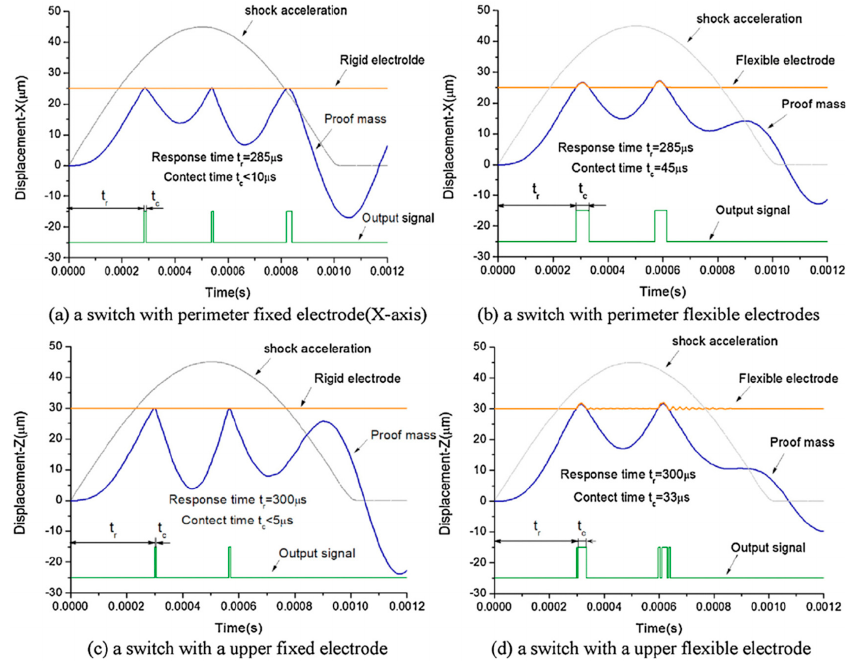
Figure 10. Simulated displacement–time curves of the proof mass in the switch under accelerations in the radial and axial direction. ( a ) A switch with rigid perimeter electrodes. ( b ) A switch with flexible perimeter electrodes. ( c ) A switch with a rigid upper electrode. ( d ) A switch with a flexible upper electrode. [17].